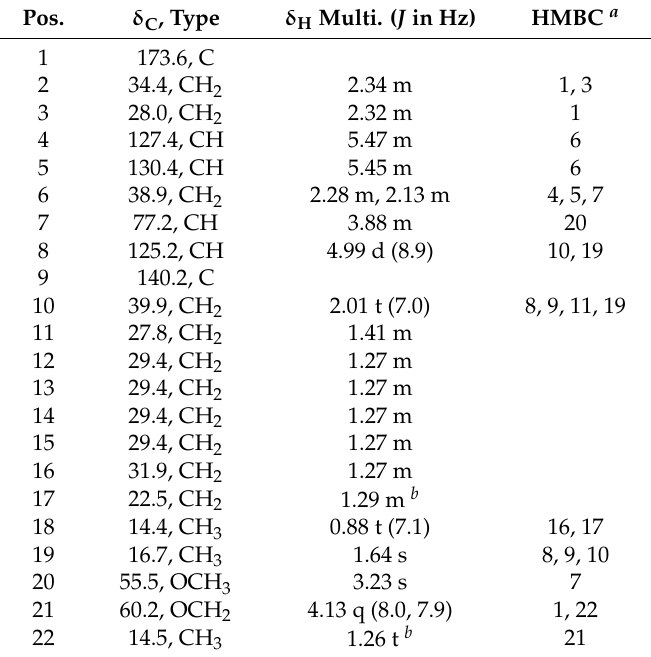
Table 2. NMR Spectroscopic data for Compound 2 in CDCl 3